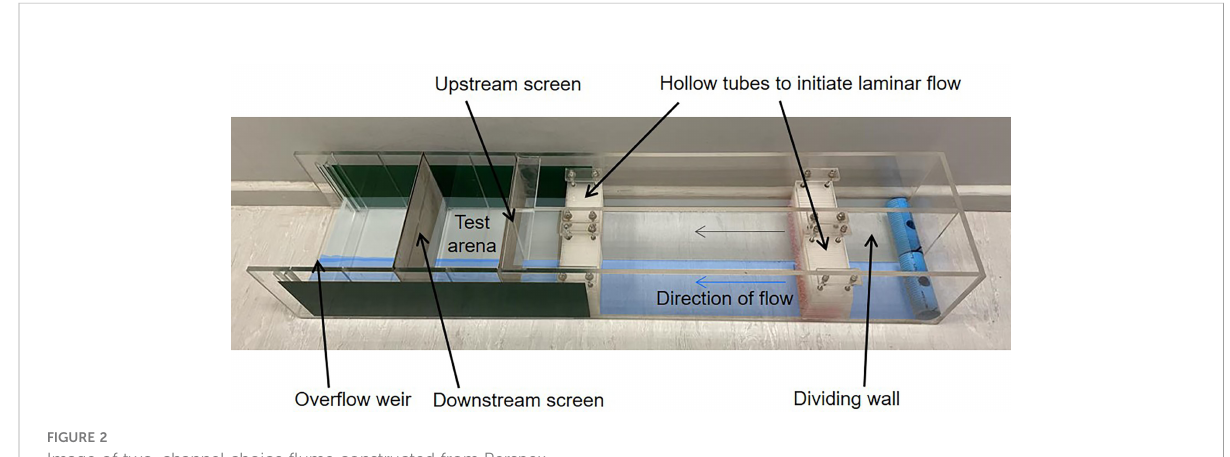
FIGURE 2 Image of two-channel choice fl ume constructed from